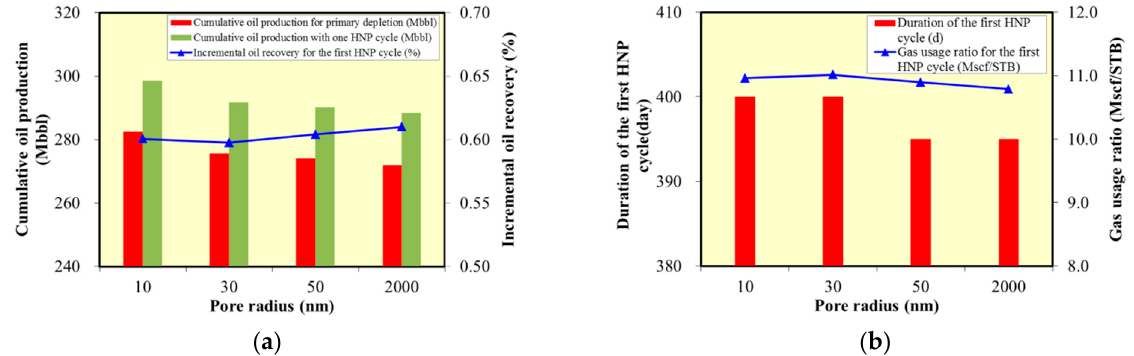
Figure 9. Correlation between pore radius of shale matrix and huff-n-puff results: ( a ) Cumulative oil production and incremental oil recovery for different pore radius of shale matrix; ( b ) Duration of the first huff-n-puff cycle and gas usage ratio for different pore radius of shale matrix.